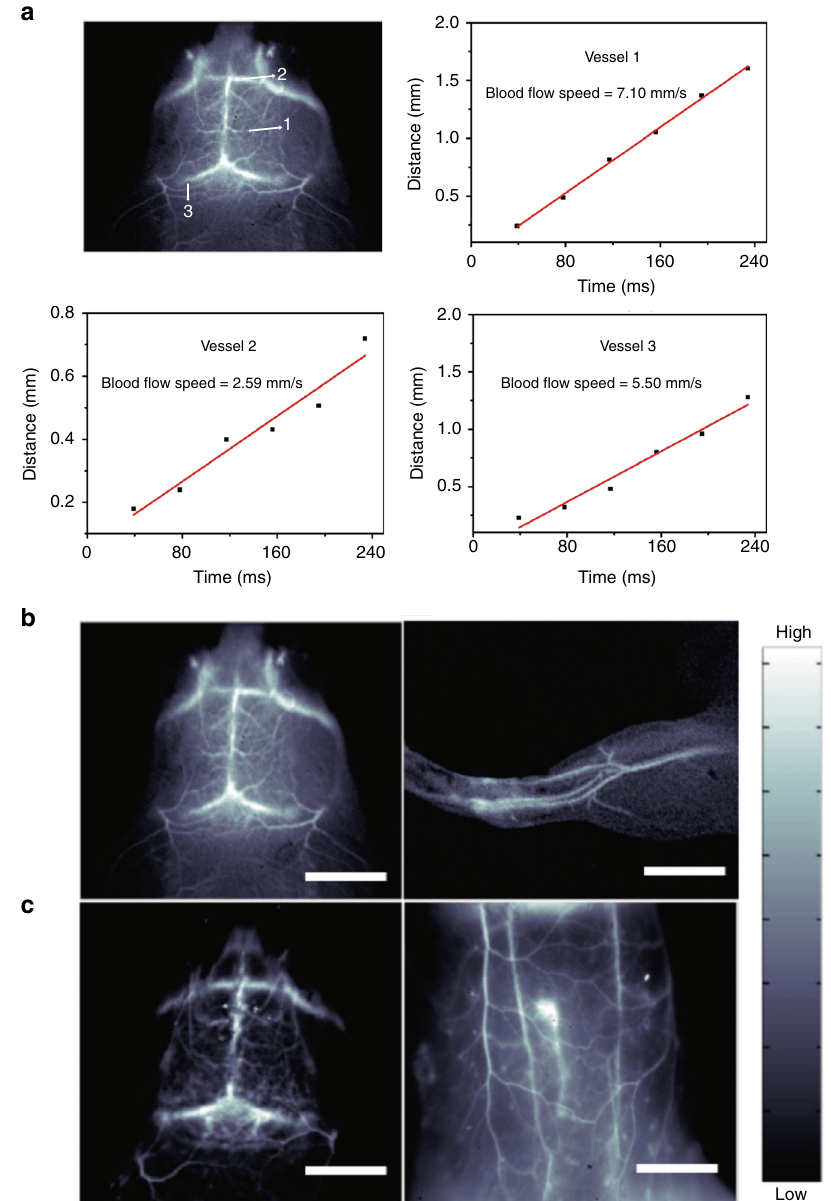
Fig. 2 Non-invasive real-time in vivo fl uorescence imaging of mice intravenously injected with p-FE. a Ultra-fast imaging of blood fl ow in brain vessels of a mouse injected with p-FE with low exposure time of 2 ms through collection of fl uorescence emitting above 1100 nm. b , c High-magni fi cation fl uorescence imaging of brain, hindlimb, and belly of the mouse through collection of fl uorescence emitting above 1100 nm with low exposure time of 2 ms ( b ) and above 1300 nm with exposure time of 20 ms ( c ). Scale bars in Fig. 2b represent 6 mm and scale bars in Fig. 2c represent 6 and 10 mm,